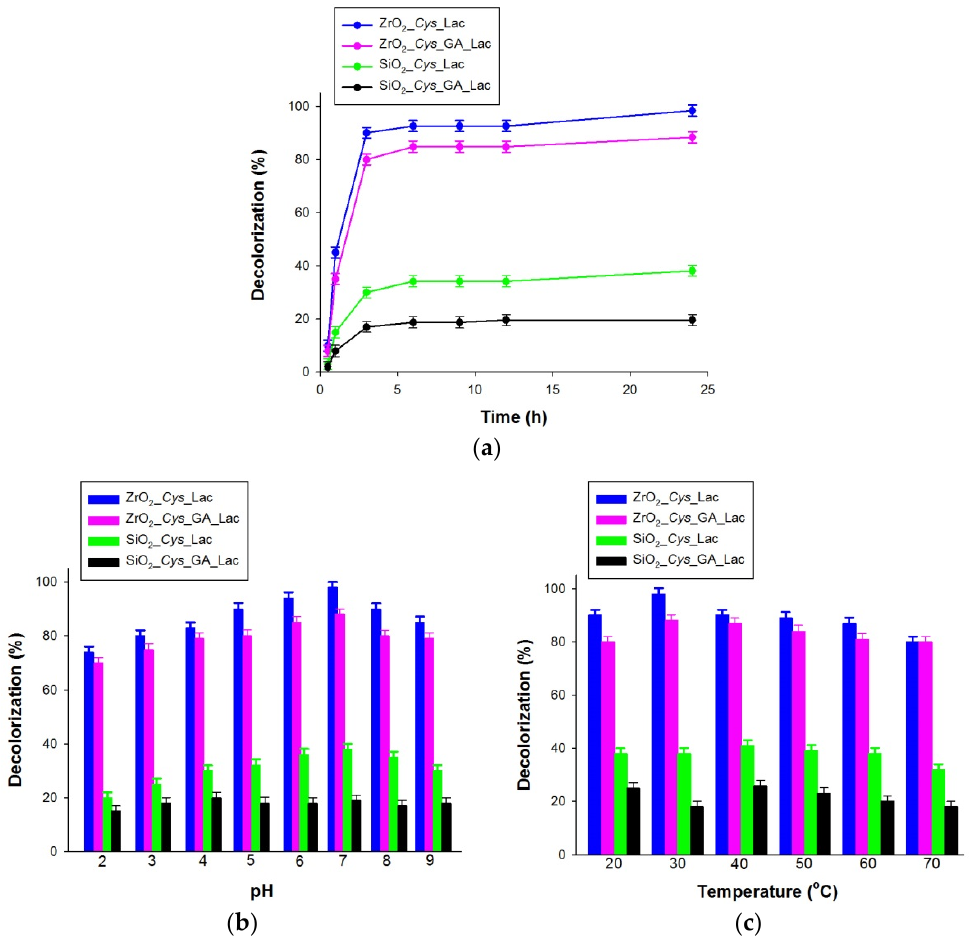
Figure 6. Effect of ( a ) process duration, ( b ) pH and ( c ) temperature on the efficiency of decolorization Figure 6. E ff ect of ( a ) process duration, ( b ) pH and ( c ) temperature on the e ffi ciency of decolorization of Alizarin Red S. of Alizarin Red